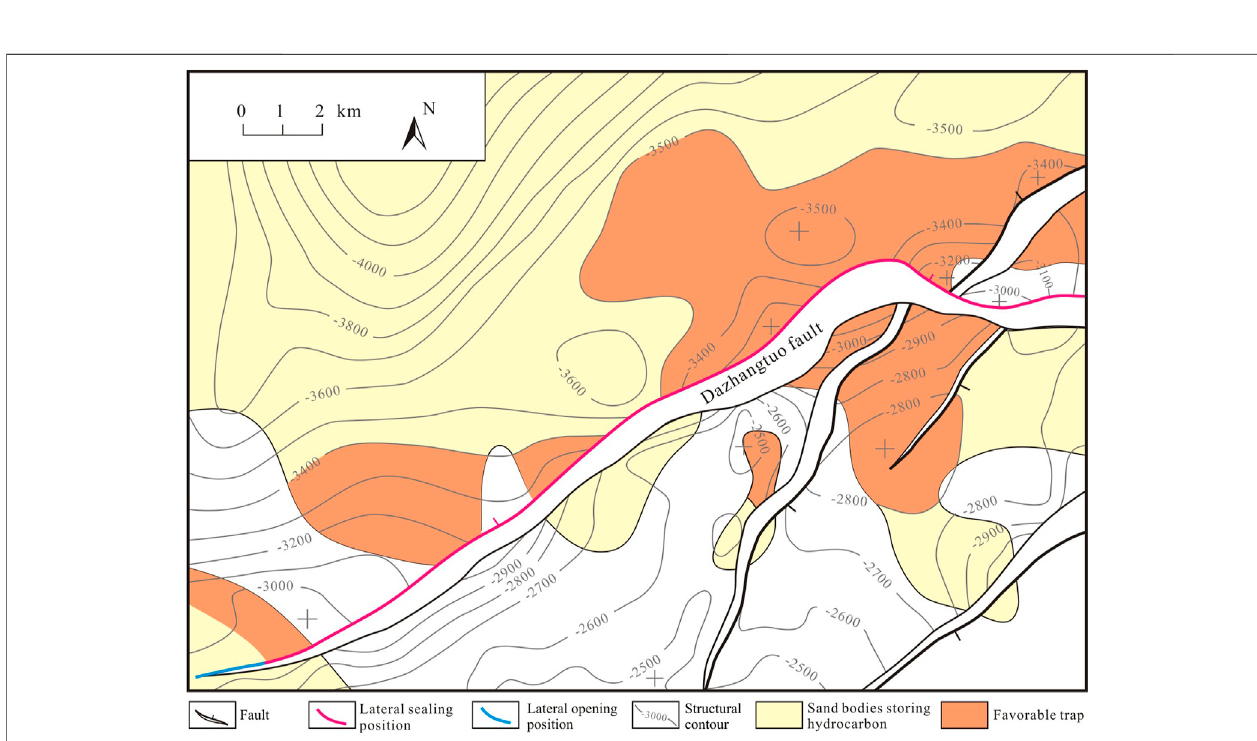
FIGURE 9 | Identi fi cation of favorable traps along the Dazhangtuo fault in the Ban 2 oil group in the Qikou Sag.